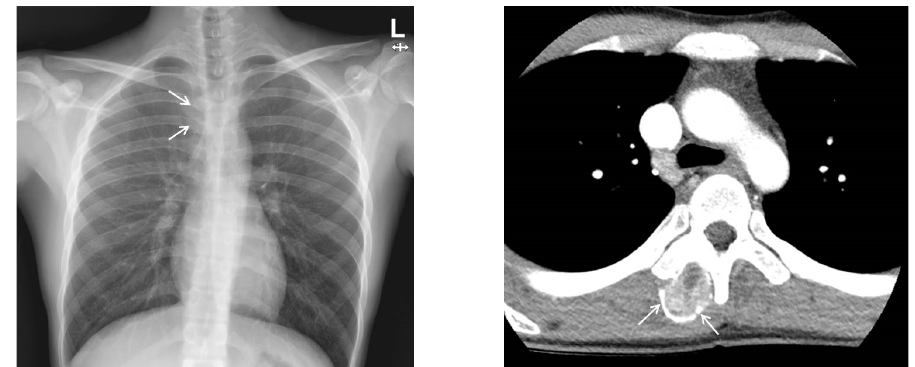
Figure 2. (Left) Chest X-ray demonstrates radiopaque mass (arrows) with rim calcification in the T4/5 paraspinal area. (Right) Axial CT scan shows an oval-shaped mass with peripheral rim calcification (arrows) in the right paraspinal muscle.